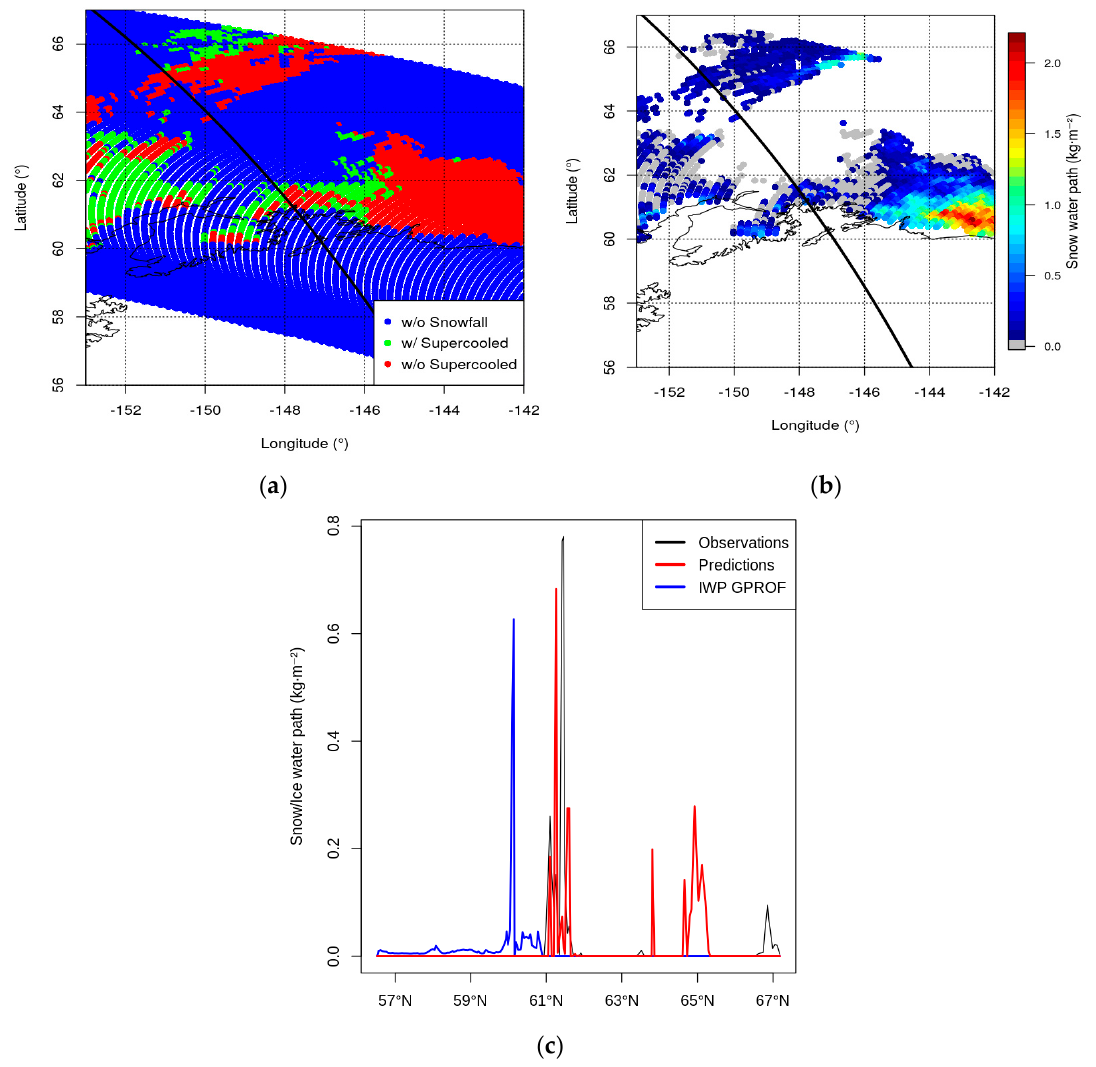
Figure 8. Same as for Figure 7 but for the 14 December 2014 event.